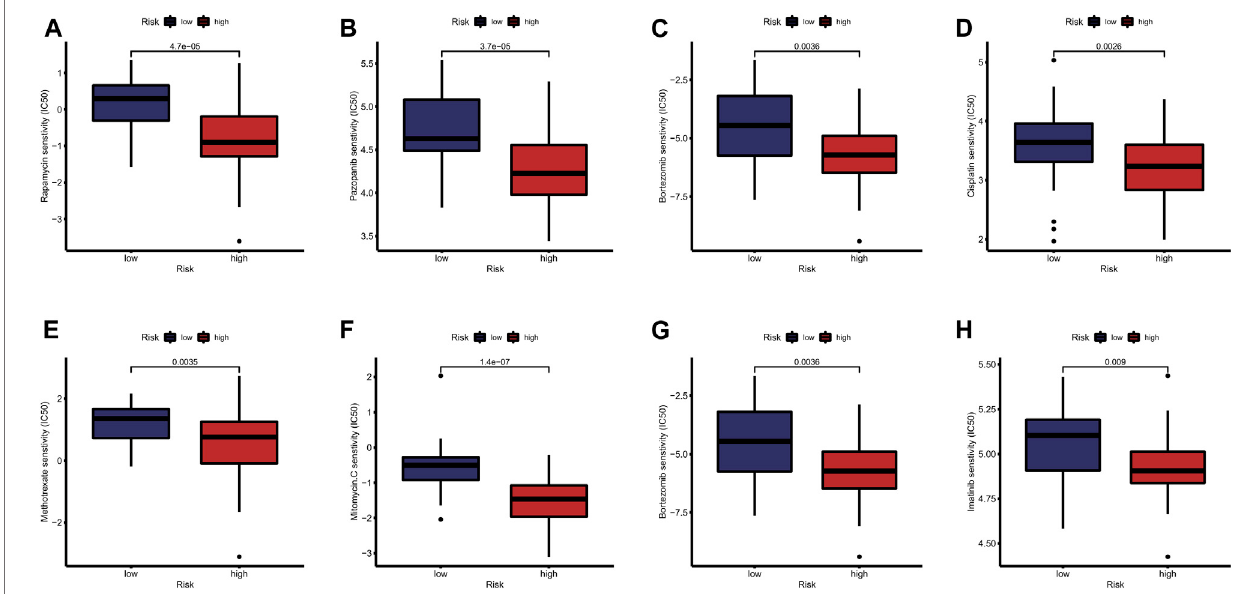
FIGURE 9 | Analysis of sensitivity difference of antitumor drugs in different groups. (A – H) The study of the sensitivity of different groups of patients to anti-tumor drugscanprovidehelpfortheformulationoffuturetreatmentregimens.BoxplotshowedthedifferentialIC 50 ofourpreviouslyestablishedhigh-riskandlowriskgroupsin the TCGA cohort. The high-risk group was more sensitive to antitumor drugs like Rapamycin, Pazopanib, Bortezomib, Cisplatin, Methotrexate, Mitomycin. C, Bortezomib and Imatinib. Those antitumor drugs were potentially more capable of inhibiting high-risk uveal melanoma with relatively minor dosage. However, further investigations are required to understand their mechanisms in Uveal Melanoma inhibition.